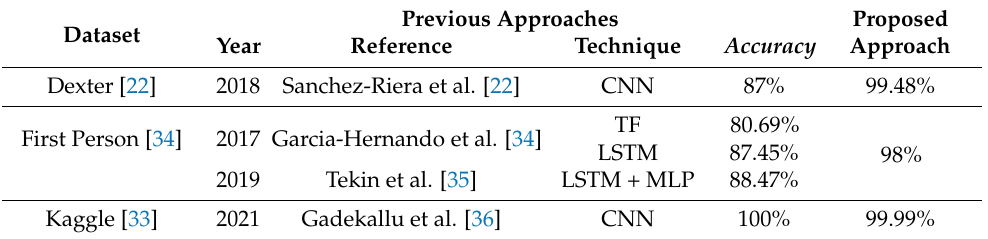
Table 6. Comparison of the proposed model with state-of-art technique for all